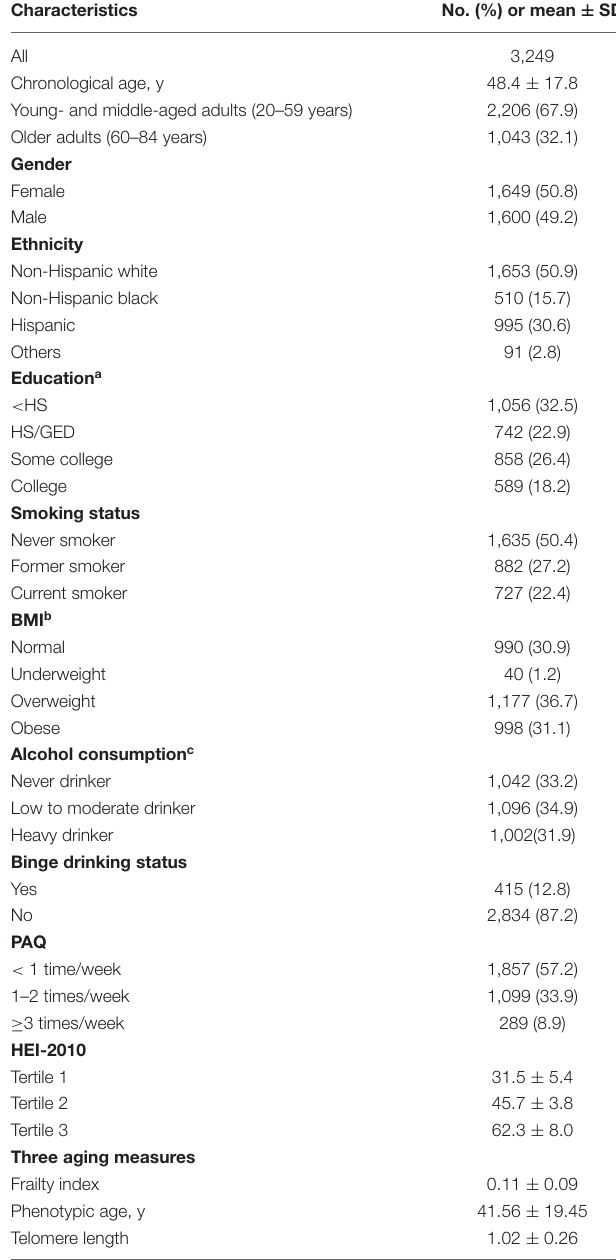
TABLE 1 | Characteristics of the study participants, NHANES 1999–2002.